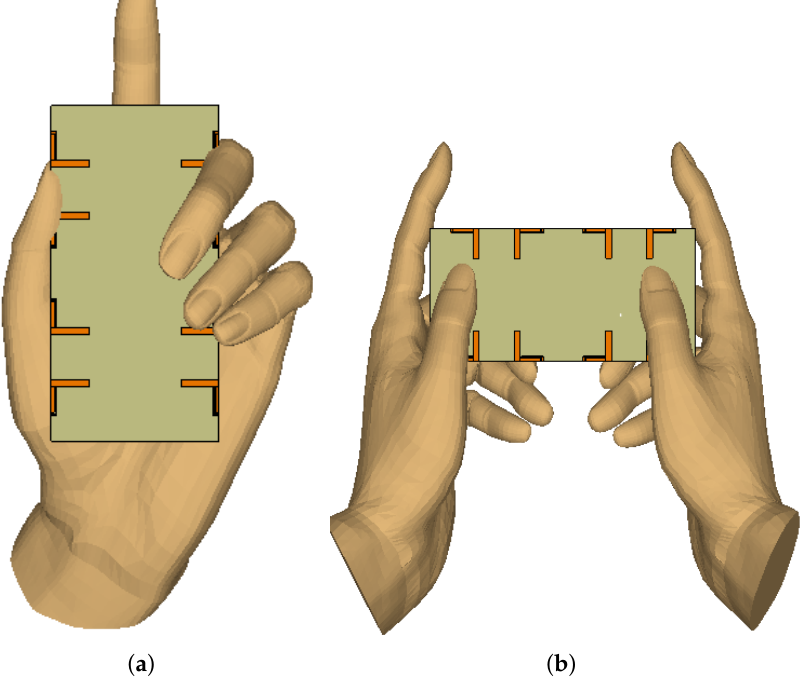
Figure 13. (a) Single-hand and (b) double-hand mode. Figure 13. ( a ) Single-hand and ( b ) double-hand